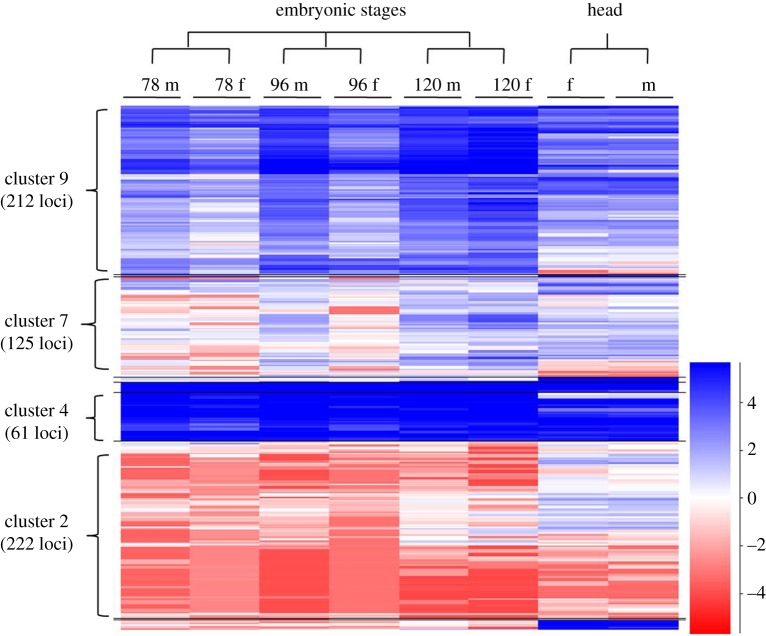
Schematic representation of Z-linked gene expression. The genes mapped to Z-linked scaffolds were segregated and their log2 FPKM values were plotted as a heatmap. The heatmap depicts a male-biased cluster 9 (212 loci) with higher expression, a female-biased cluster 2 (222 loci) with lower expression, cluster 7 (125 loci) represents genes with varied expression and an unbiased cluster 4 (61 loci).